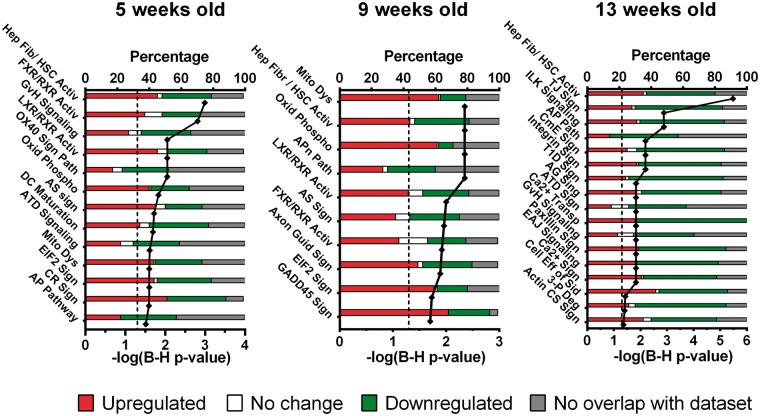
Global canonical pathways that may play a role in cerebrovascular
remodelling in the SHR at various stages of hypertension
development. The pathways were derived from transcriptomic
changes between age-matched SHR and WKY rats and sorted
according to the likelihood of involvement in the SHR cerebral
artery phenotype such as immune system in the pre-hypertensive
SHR. At the onset of the hypertension the stress signalling
genes (e.g. GADD45) is upregulated and only after hypertension
is established does endothelial dysfunction occur. This
indicates that vascular remodelling at the pre-hypertensive
stage is different to that during established hypertension. The
onset of hypertension triggers an intermediate phenotype,
presumably as a response to the increasing blood pressure. The
p values are corrected for false discovery
rate (Benjamini–Hochberg correction). The stacked bar columns
represent the percentage of genes involved in a particular
signalling pathway and their expression level compared to
age-matched control rats (WKY). Hep Fib/ HSC Activ: hepatic
fibrosis / hepatic stellate cell activation; FXR/RXR Activ:
FXR/RXR activation; GvH: Graft-versus-Host disease; LXR/RXR
Activ: LXR/RXR activation, OX40 Sign Path: OX40 signalling
pathway; Oxid Phospho: oxidative phosphorylation; AS:
atherosclerosis signalling; DC Maturation: dendritic cell
maturation; ATD Signalling: autoimmune thyroid disease
signalling; Mito Dys: mitochondrial dysfunction, EIF2 Sign: EIF2
signalling; CR sign: circadian rhythm signalling; AP Pathway:
antigen presentation pathway, Axon Guid Sign: axonal guidance
signalling; GADD45 Sign: GADD45 signalling; TJ Sign: tight
junction signalling; ILK: integrin linked kinase; CmE:
clathrin-mediated endocytosis signalling; T1D sign: type I
diabetes mellitus signalling; AG Sign: axonal guidance
signalling; Ca2+ Transp: calcium transport; EAJ: epithelial
adherens junction; Ca2+ Sign: calcium signalling; Cell Eff of
Sid: cellular effects of sildenafil; 3-P Deg: 3-phosphoinositide
degradation; Actin CS Sign: actin cytoskeleton signalling.